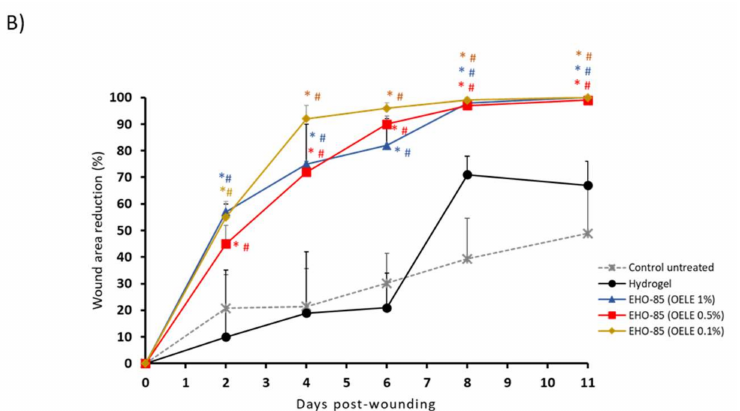
Figure 5. Wound-area reduction evolution in mice (db/db; BKS.Cg-m +/+ Leprdb) treated with EHO-85. ( A ) Images of the healing evolution at 0, 4, 8, and 11 days after wounding in the four treatment groups: hydrogel without OELE, EHO-85 hydrogel (1% OELE), EHO-85 hydrogel (0.5% OELE), and EHO-85 hydrogel (0.1% OELE). Left wounds were used as a control of the healing evolution in all animals (untreated). ( B ) Graphical representation of the mean evolution of wound closure in the different treatment groups. * p < 0.05 vs. wounds treated with hydrogel without OELE. # p < 0.5 vs. wounds untreated